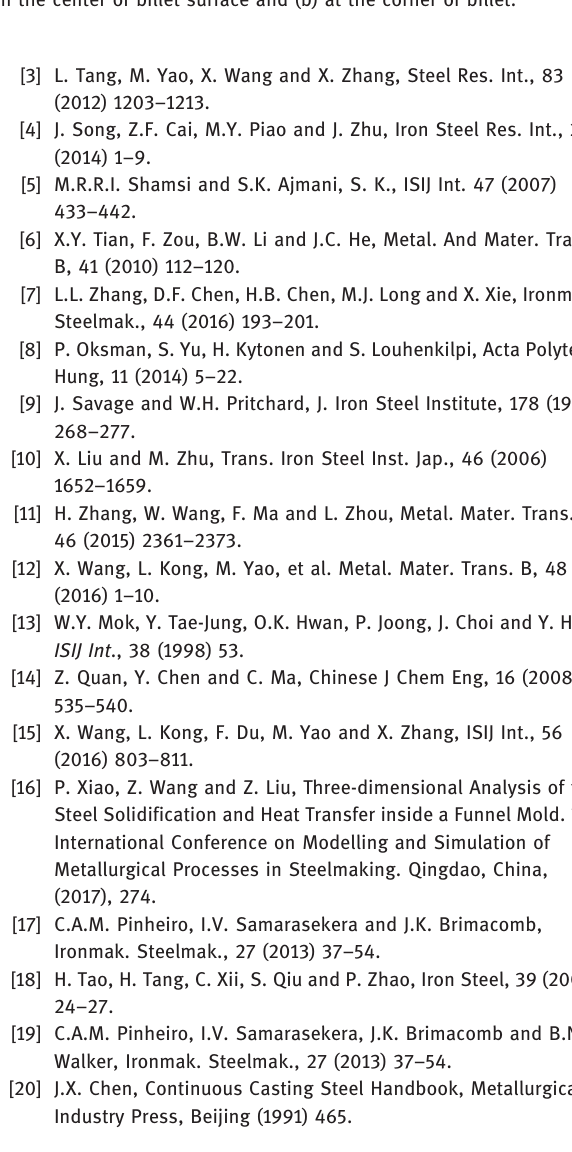
Figure 10: Solidification law of billet for different scale thickness (a) in the center of billet surface and (b) at the corner of